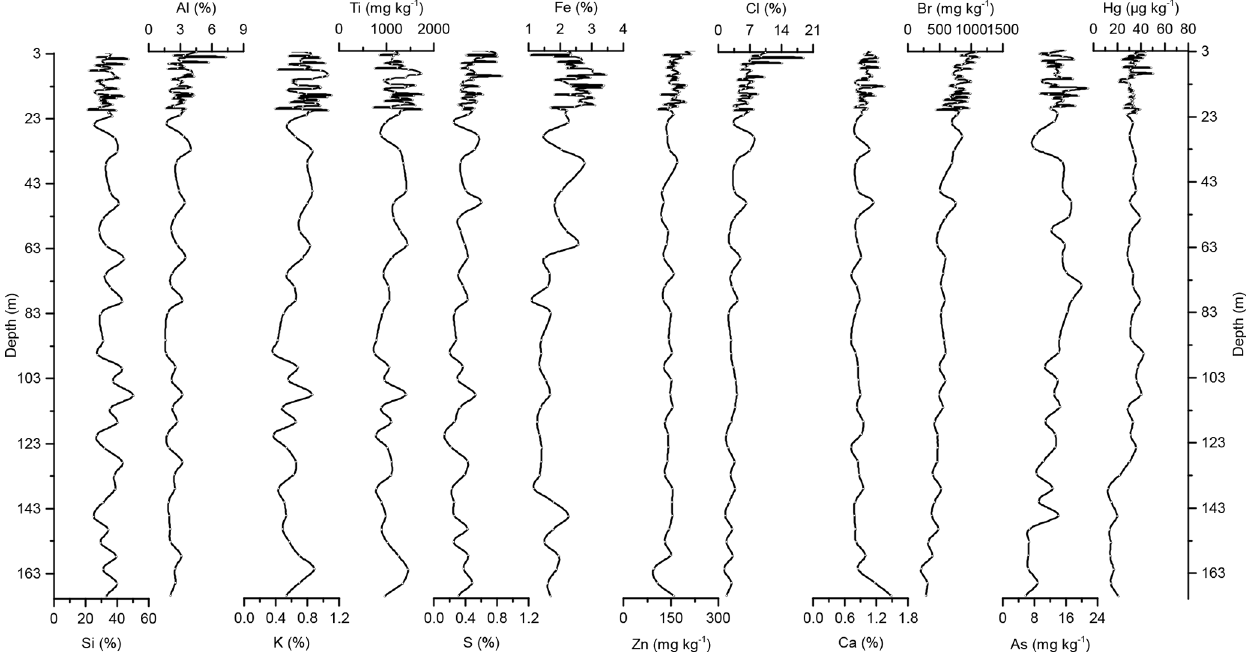
Figure 2. Down-core records of Si, Al, K, Ti, S, Fe, Zn, Cl, Ca, Br, As, and Hg concentrations of Adélie Basin sediments.